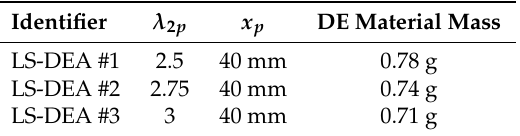
Table 2. Features of the tested experimental